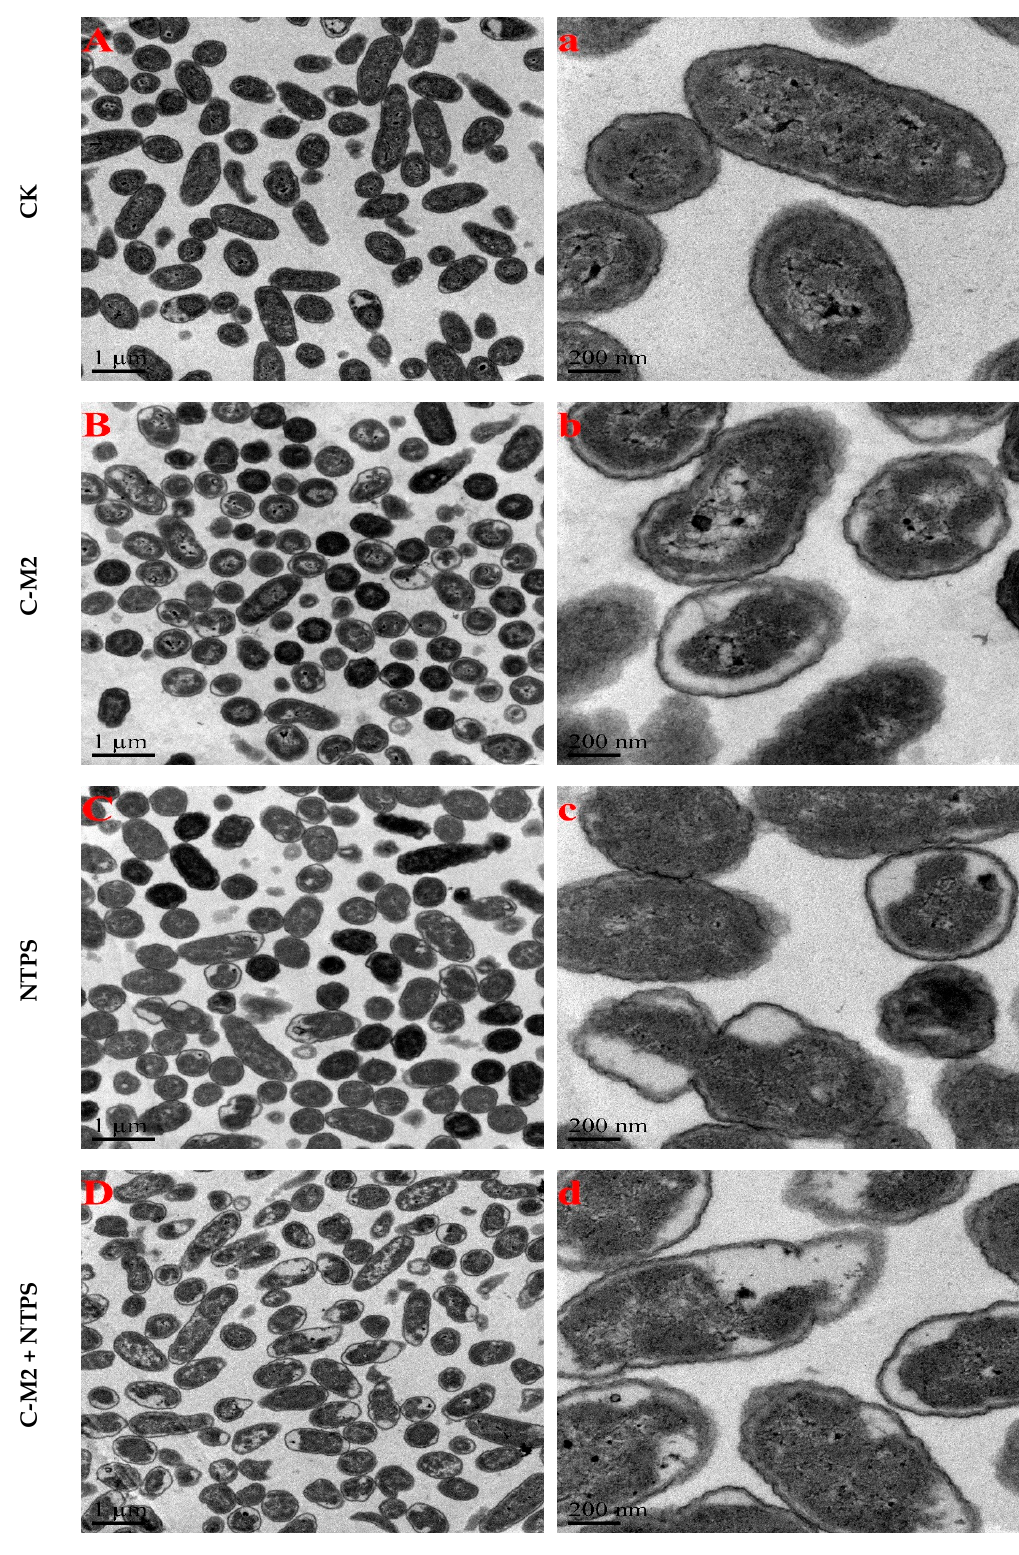
Figure 3. Transmission electron microscopy of Morganella sp. wf-1 cells with different treatments. Figure ( A , a ) represent untreated control cells; Figure ( B , b ), ( C , c ) and ( D , d ) represent cells treated by C-M2, NTPS and CM2 + NTPS, respectively. Scale bars in ( A – D ) = 1 µ m; scale bars in ( a – d ) = 200